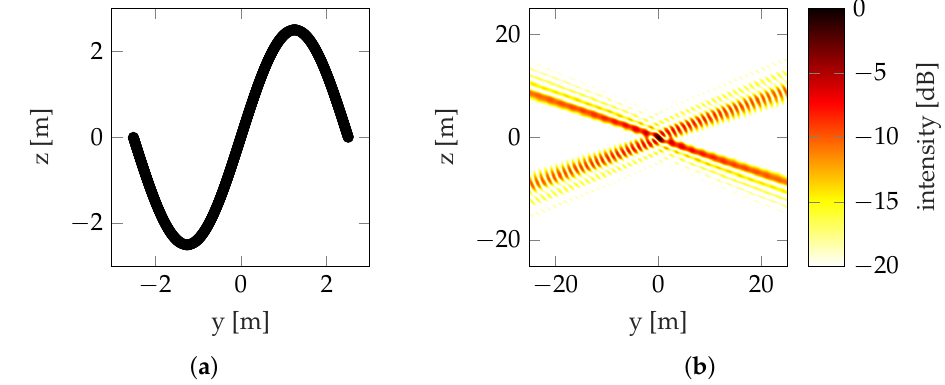
Figure 5. Sinusoidal trajectory/HAT maneuver example: ( a ) Trajectory. ( b )